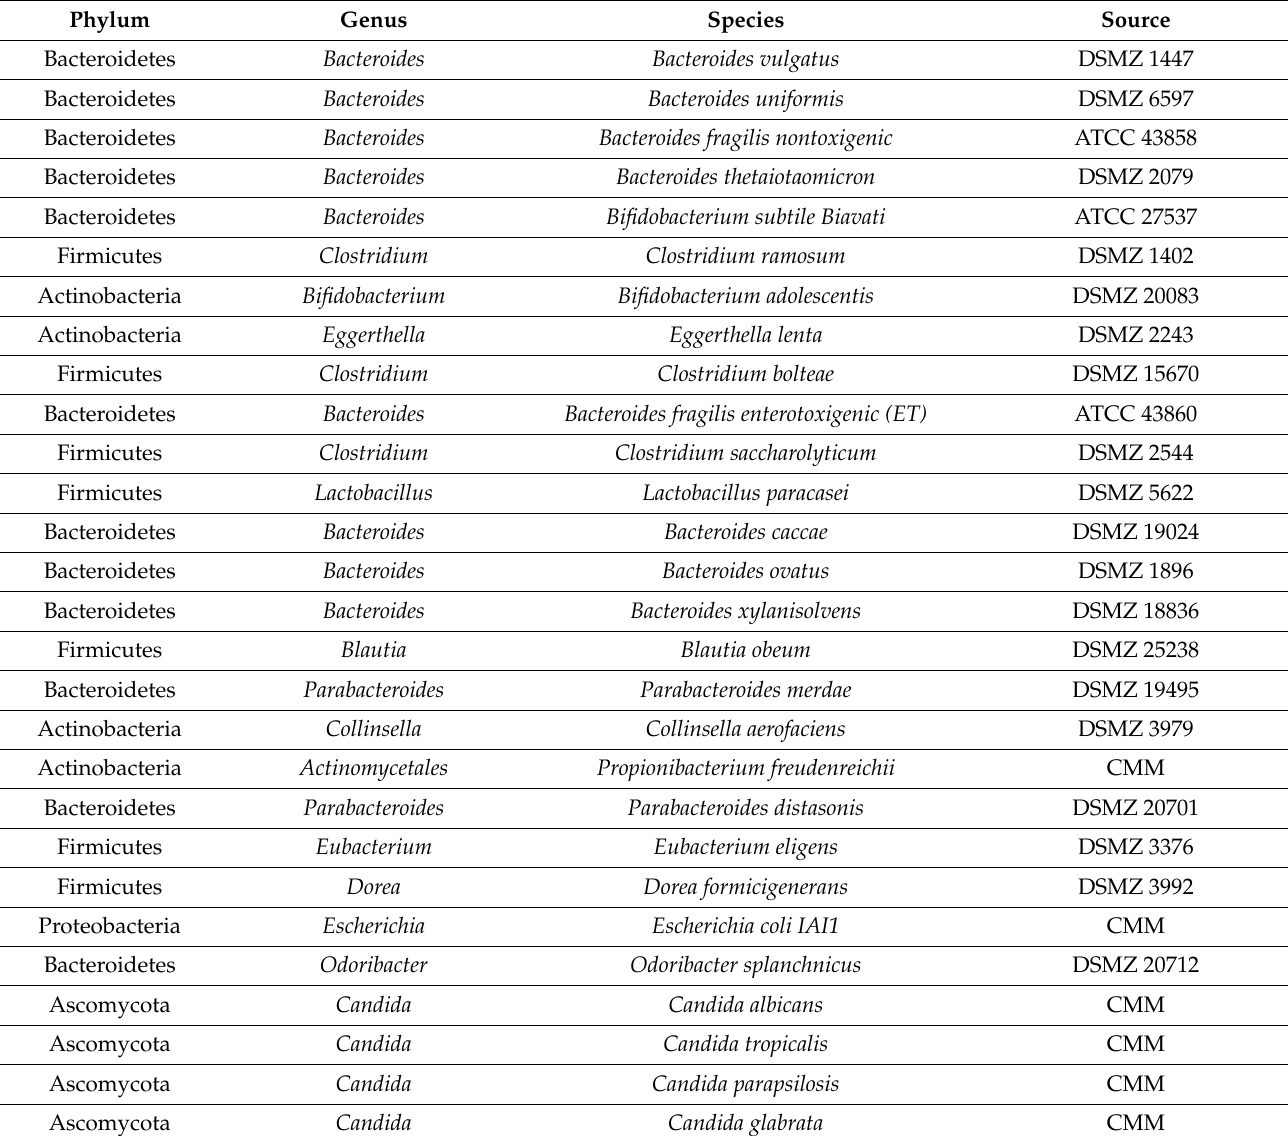
Table 2. Representative microbial species commonly found in the human gastrointestinal